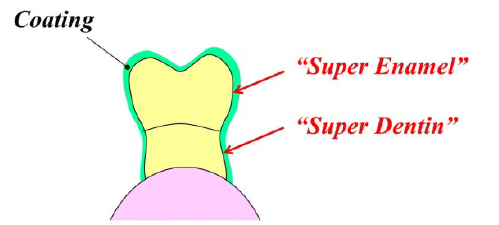
Figure 9. Root surface coating with the dentin bonding systems; Covering the exposed